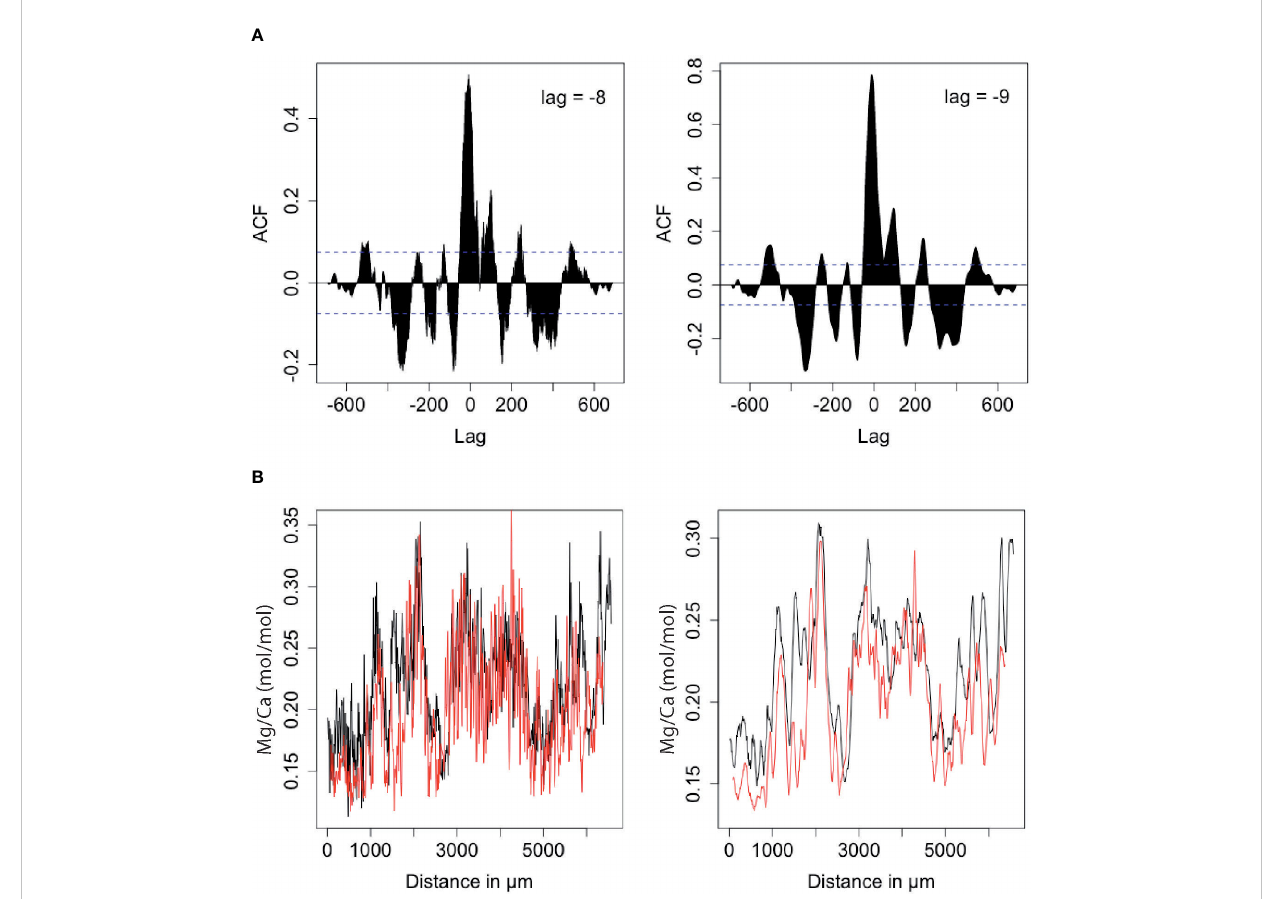
FIGURE 3 Cross-correlation of Mg/Ca transects (from left to right: 2017-2012). (A) Cross-correlation of Mg/Ca time series neo40.1 and neo40.2; left graph shows full resolution data, right graph 10 point running mean. (B) Best fi t of Mg/Ca curve of neo40.2 (black curve) and Mg/Ca curve of neo40.1 (red curve) already corrected for calculated lag; left graph raw data, right graph 10 point running mean. ACF in (A) stands for “ auto-correlation function ” , which displays coef fi cients of correlation between time series and its lagged